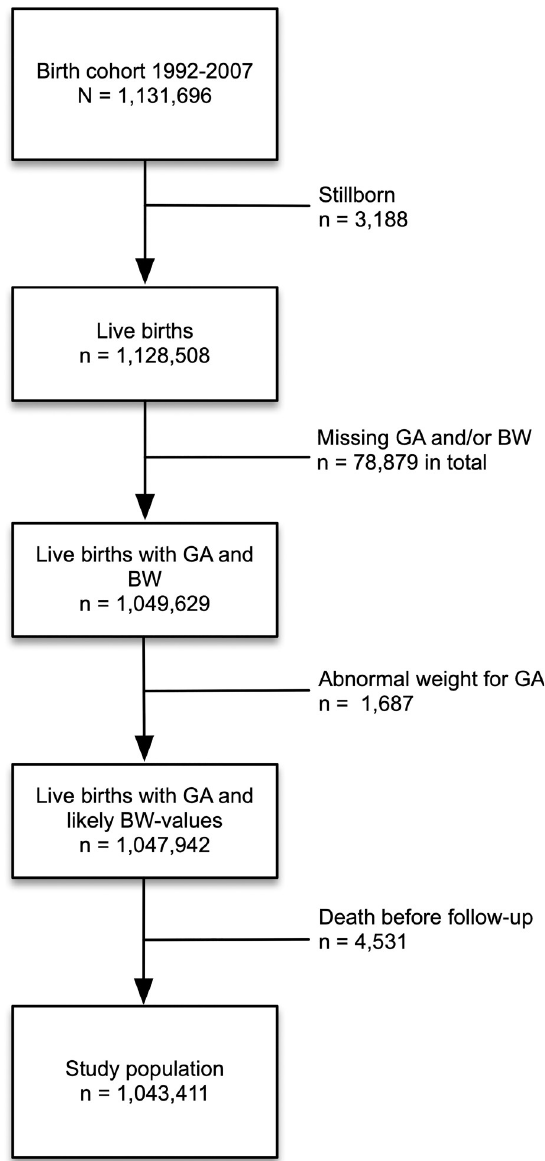
Fig 1. Flow-chart with exclusions from national birth cohort to final study population. GA: gestational age, BW: birth weight.